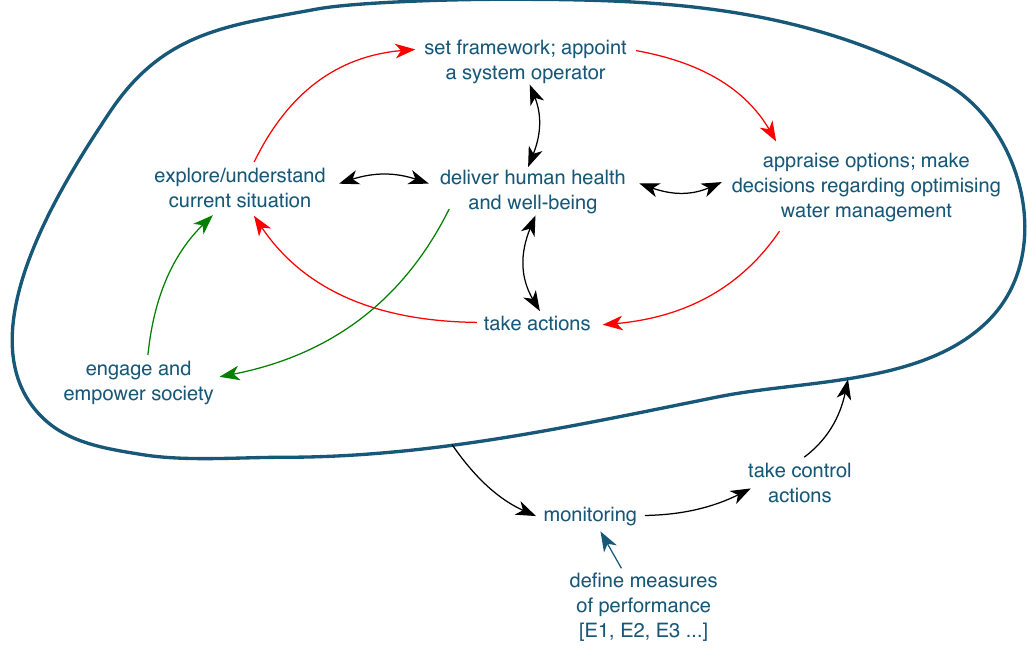
Figure 4. A conceptual model of an ‘ideal’ water governance system constructed by a group